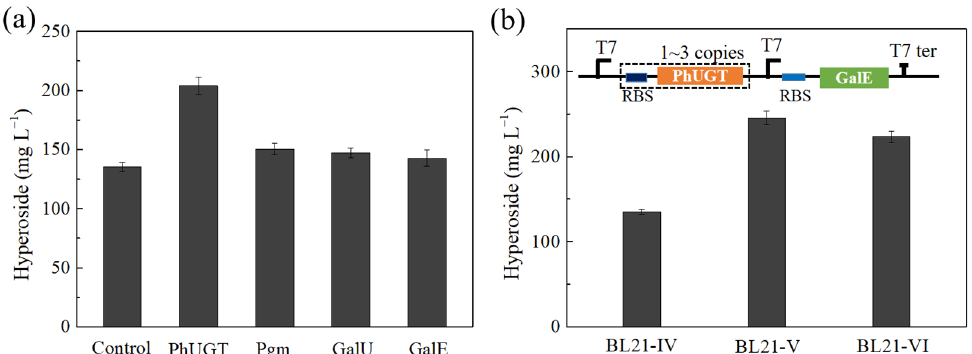
Figure 4. Optimization of the expression of PhUGT in the co-expression strain by different copies. ( a ) Hyperoside production by strain BL21-IV with the exogenous addition of 200 mU·mL − 1 PhUGT, Pgm, GalU, or GalE. ( b ) The production of hyperoside in the co-expression strain with different copies of PhUGT. BL21-IV, one copy; BL21-V, two copies; BL21-VI, three copies.